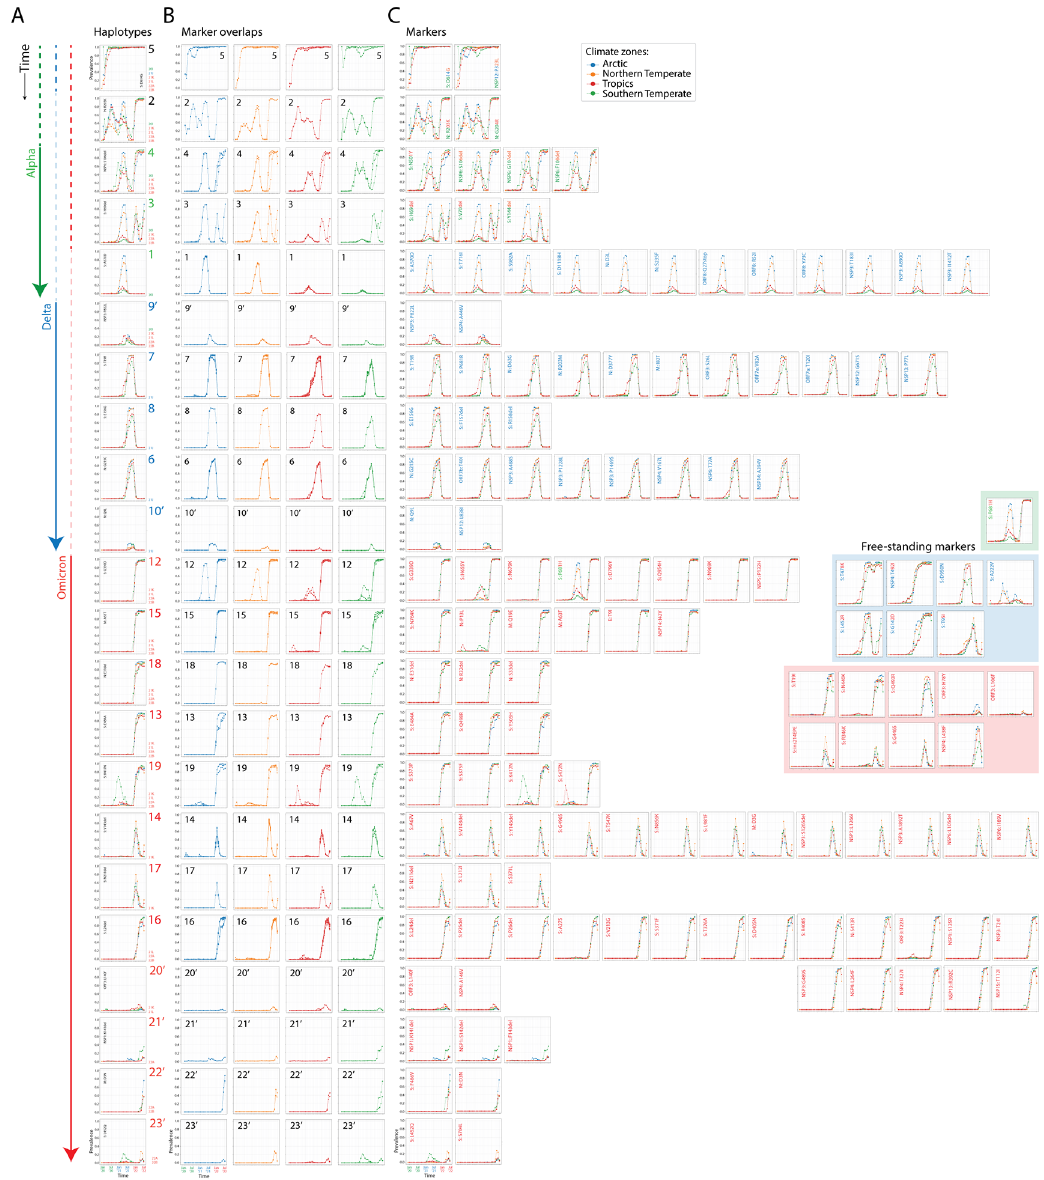
Figure 2.Achronologyof SARS-CoV-2haplotypes. (A)Accumulationplotsillustratinghaplotypes emergingalong a timeline of the pandemic with labels colored according to VOCs they belong and time unfolding from top to bottom. The accumulation plot of a single mutant illustrates each haplotype. (B) Accumulation plot overlaps of all mutant markers of haplotypes describe haplotype decoupling for individual climatic zones. (C) Accumulation plots for mutants belonging to each haplotype are displayed from left to right. Mutant names are colored according to the VOCs they belong. The inset shows accumulation plots for free-standing